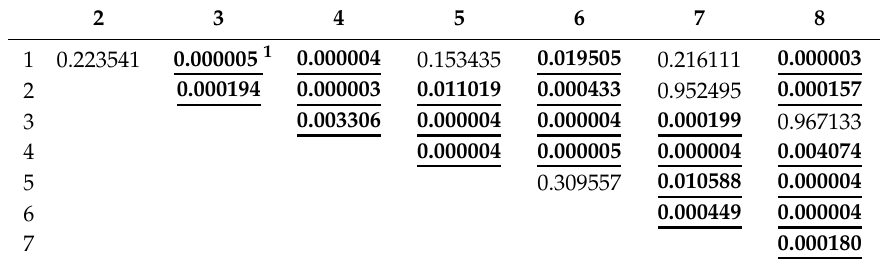
Table A5. Results of a pairwise comparison of the total species composition of the eight association groups according to Duncan criterion.